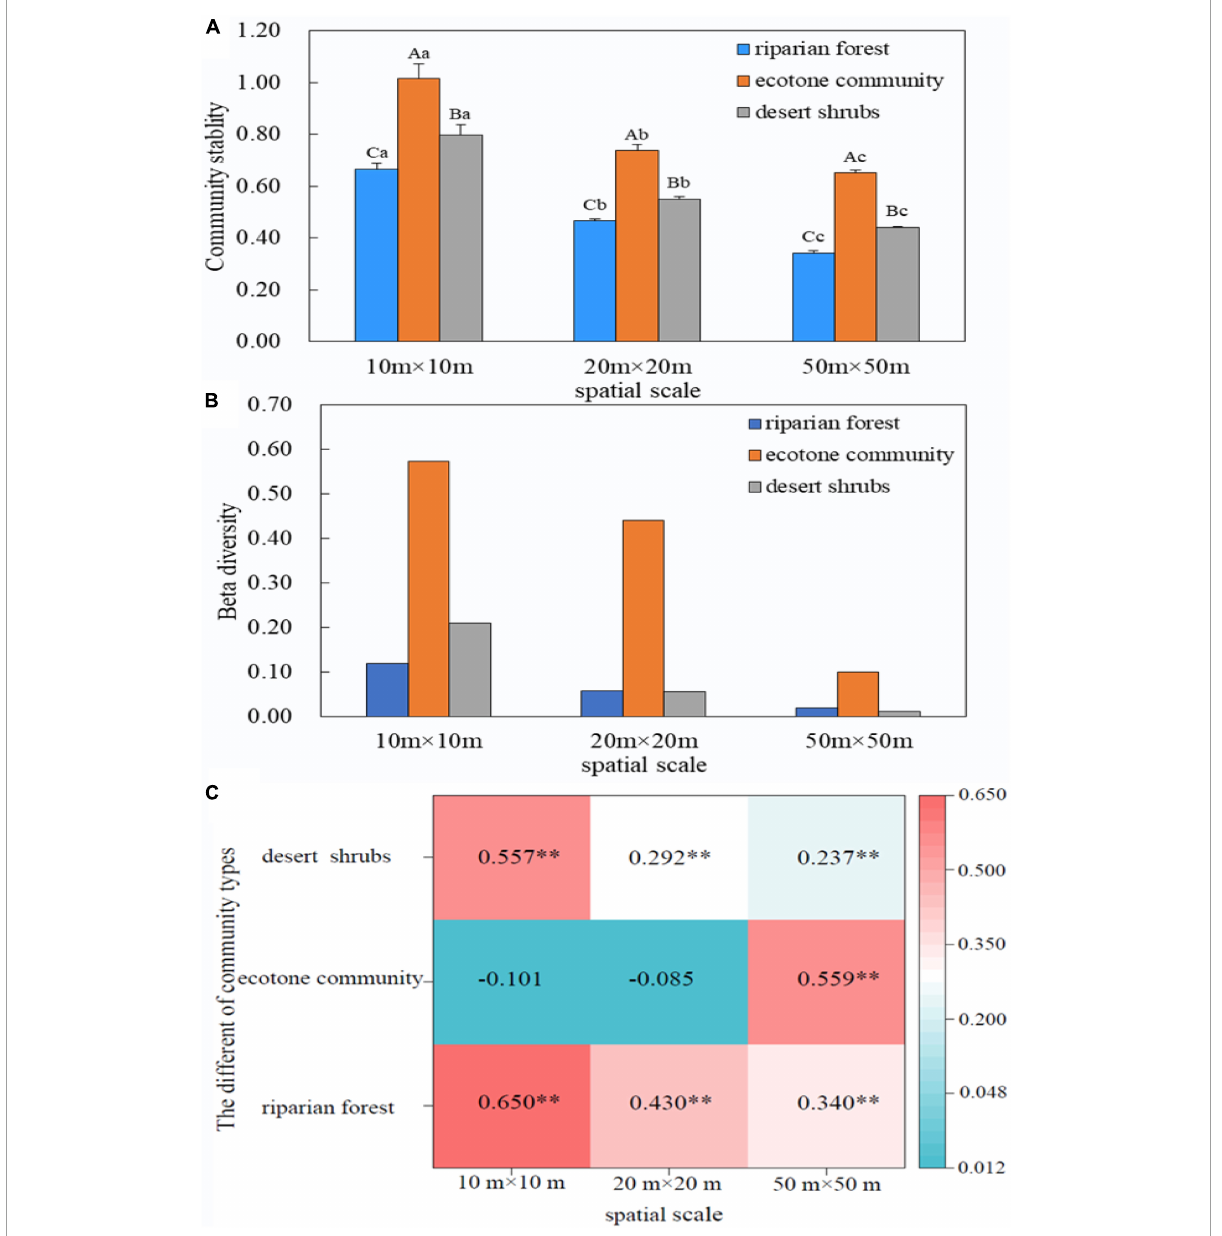
FIGURE2 Relationship between community stability and β diversity. (A) Variation of community stability across spatial scales; (B) Variation of β diversity across spatial scales; (C) Relationship between LCBD and community stability. The capital letters indicate the difference of the stability between different communities at the same spatial scale, while the lower letters suggest the difference of the stability of the same community among different spatial scales. P < 0.05. ∗∗ P <